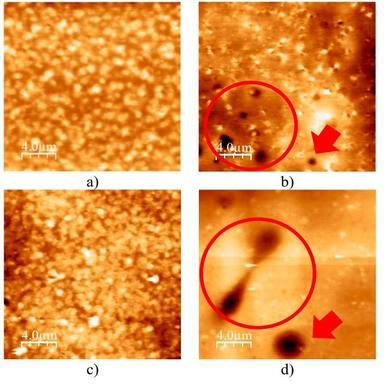
AFM images: a) DGH, b) DGW, c) OGH and d) OGW specimens. SBSpolymers are indicated by red arrows and circles. (For interpretation of the references to colour in this figure legend, the reader is referred to the web version of this article.)